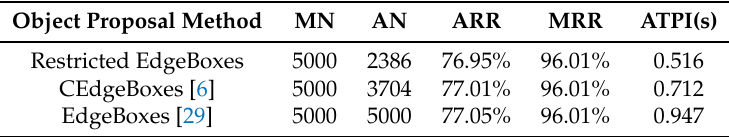
Table 1. Performance of different object proposal